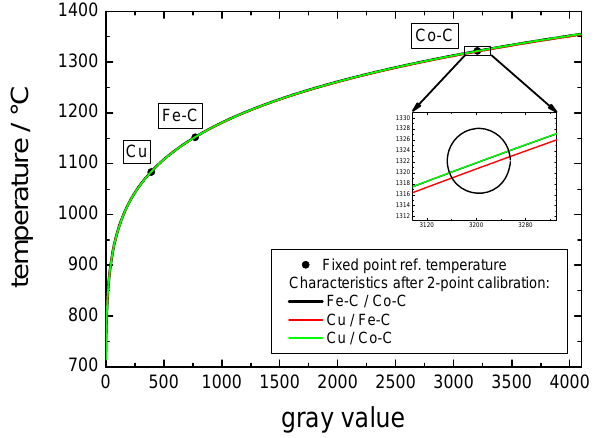
Figure 12. Melt and freeze cycle of an inductively heated Co–C fixed-point cell (cavity diameter 5mm) after on-site calibration of the laser processing head at an industrial machine for laser hardening of steam turbine blades (Fraunhofer IWS Dresden, Germany). The inflection point of the melt plateau agrees with reference temperature (linear pyrometer LP3 at PTB Berlin) within ± 0.5K.